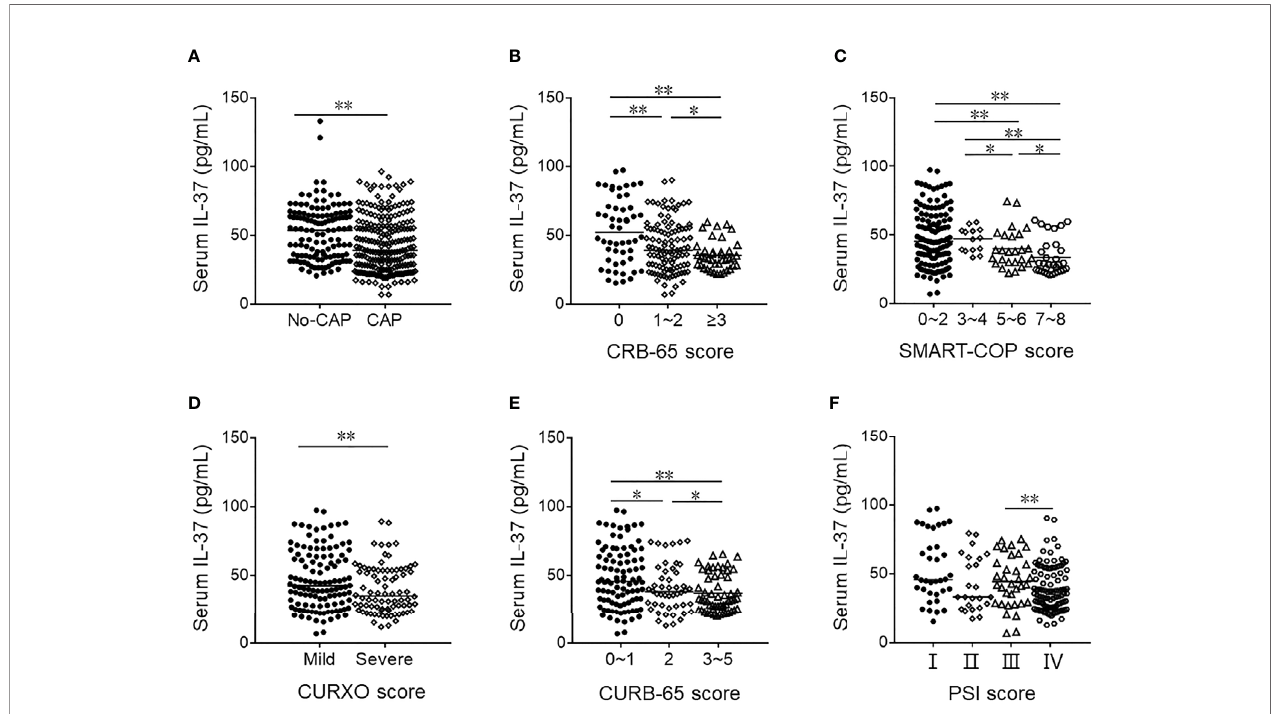
FIGURE 2 | The levels of serum IL-37 in No-CAP and CAP cases. (A – F) The level of serum IL-37 was detected with ELISA. (A) The level of serum IL-37 in CAP patients and control subjects. (B) The level of serum IL-37 in different ranks of CRB-65 score of CAP. (C) The level of serum IL-37 in different ranks of SMART-COP score of CAP. (D) The level of serum IL-37 in different ranks of CURXO score of CAP. (E) The level of serum IL-37 in different ranks of SMART-COP score of CAP. (F) The level of serum IL-37 in different ranks of PSI score of CAP. * P < 0.05, ** P < 0.01.